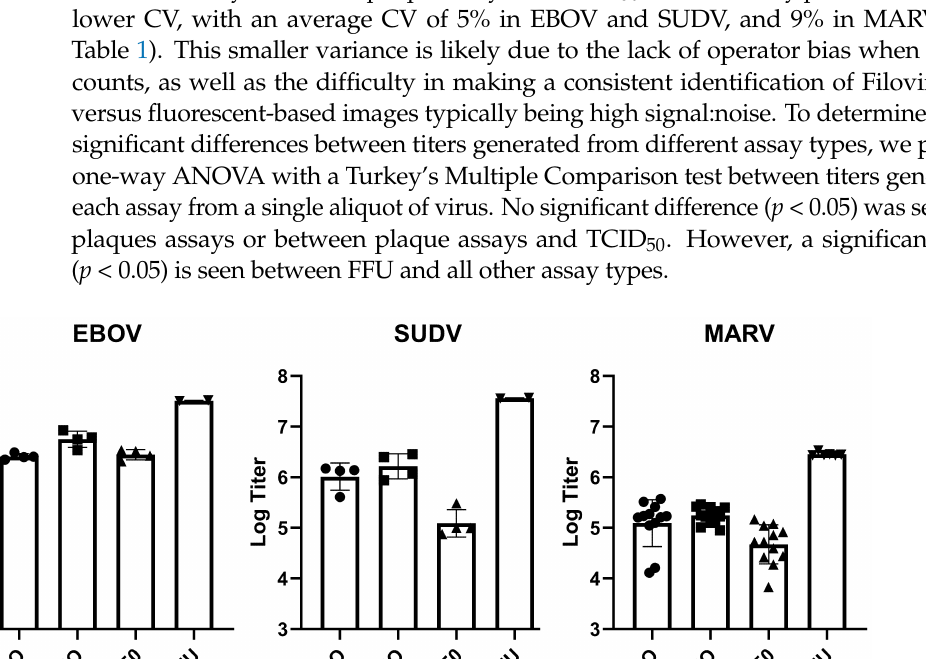
Microorganisms 2021 , 9 , x FOR PEER REVIEW